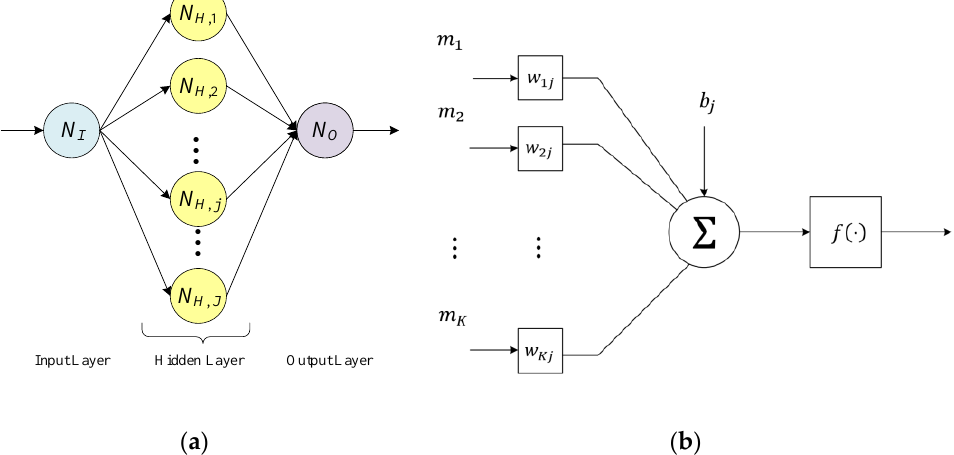
Figure 3. Illustration of the proposed ANN predistorter: ( a ) The structure of an artificial neural network; ( b ) the structure of a specified neuron 𝑗 .